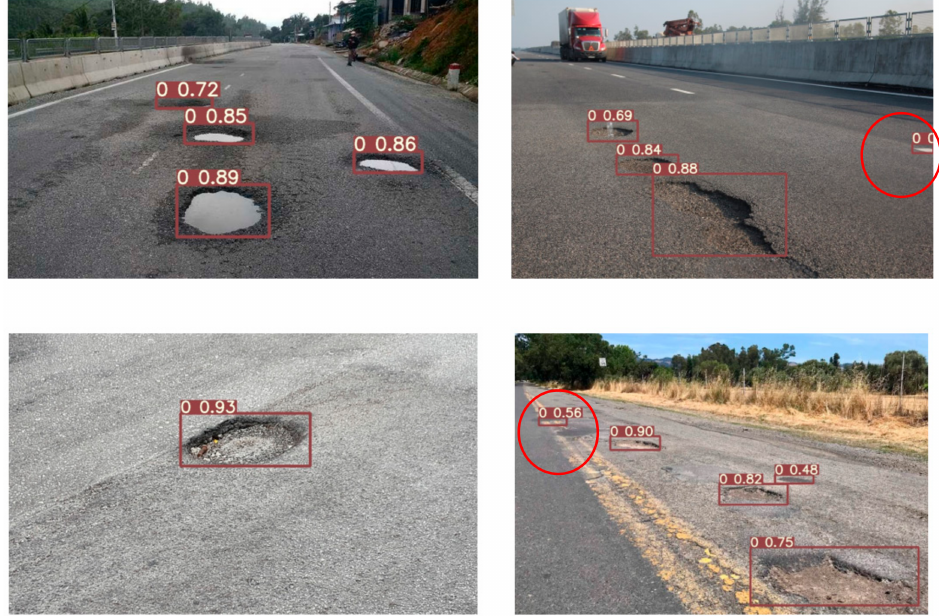
Figure 11. Detection results of